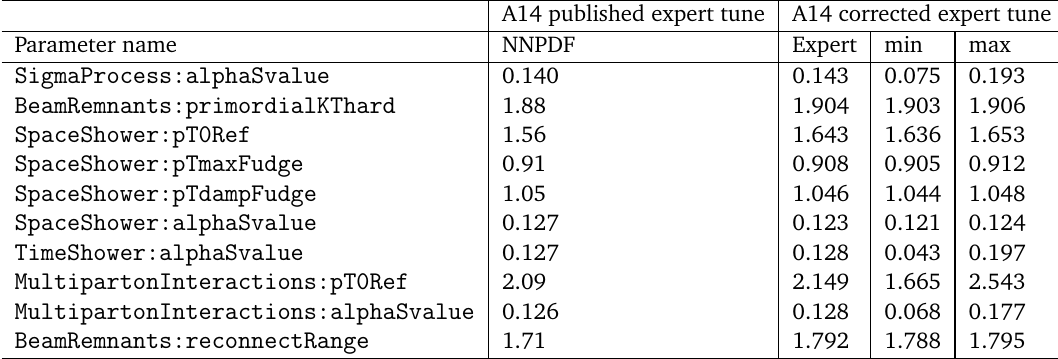
Table 3: Parameter values for A14 published tune (left), and A14 corrected expert tune and corresponding eigentune 68% confidence intervals